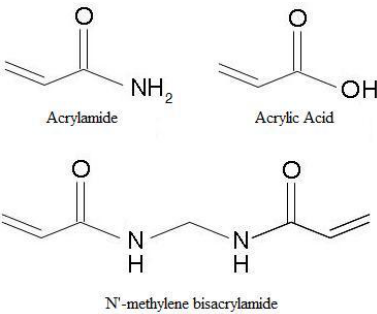
Figure 6. Chemical similarities between acrylamide, acrylic acid and N '-methylene bisacrylamide.